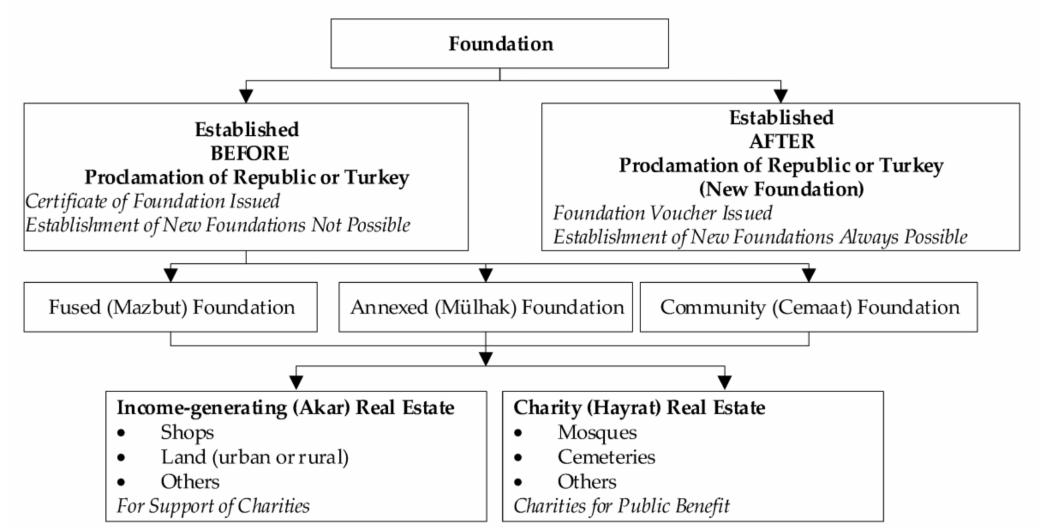
Figure 3. Types of Foundations in Turkey (Adapted from [11]).